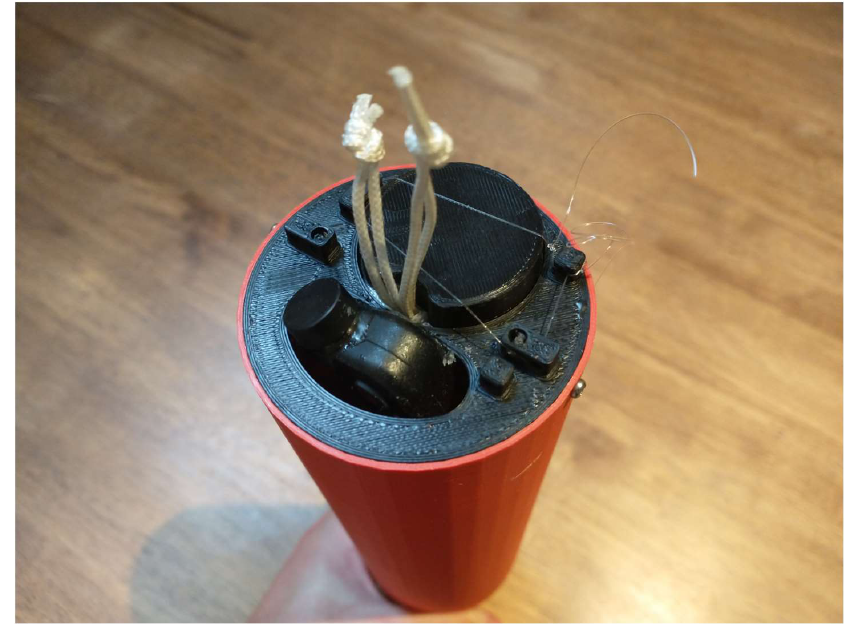
Figure 17. Rear of capsule, with circular parawing container “cap” at top, pinpuller lugs at right and left.